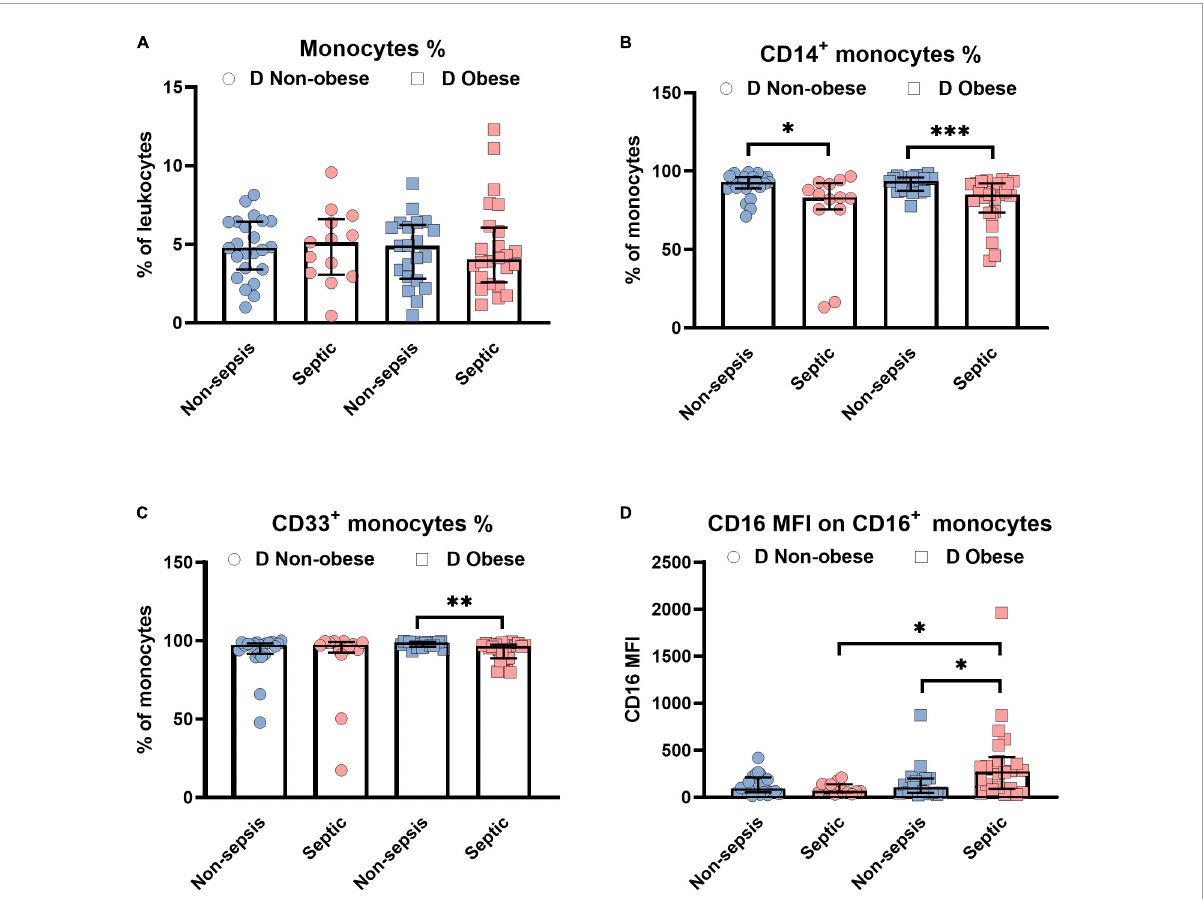
FIGURE3 Influence of obesity on monocytes in diabetic (D) patients with or without sepsis status. Distribution changes in the percentage of monocytes among the total leukocyte population (A) and the percentage of CD14 + monocytes (B) and CD33 + monocytes among the monocyte population (C) . (D) Surface phenotype expression of CD16 on positive monocytes determined by mean fluorescence intensity (MFI). Data are presented by scatter with bar plots. Due to the small sample sizes, the non-obese and obese groups were not divided into sepsis (non-obese, n = 9; obese, n = 13) and septic shock (non-obese, n = 4; obese, n = 11) subgroups, rather presented as a combined “septic” group. Results are medians with interquartile range. Mann-Whitney U -test was used to analyze the differences between two groups. Significant difference is marked by ∗ p < 0.05, ∗∗ p < 0.01, and ∗∗∗ p <